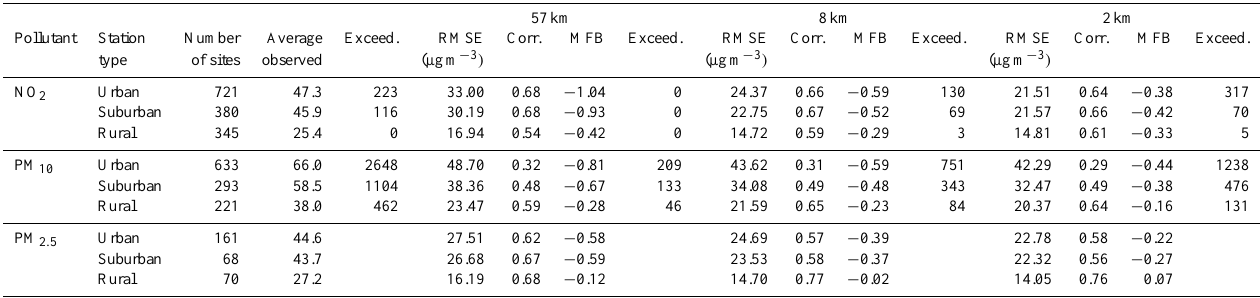
Table 1. Model performances (root mean square error, mean fractional bias and average spatial correlation) of each configuration over the whole modelling domain for three types of background stations (urban, suburban, rural) between 9 and 16 January 2009. The average of observations over the whole period is also given as well as the number of exceedances (Exceed.) of regulatory thresholds: 200µgm − 3 for hourly NO 2 and 50µgm − 3 for daily PM 10